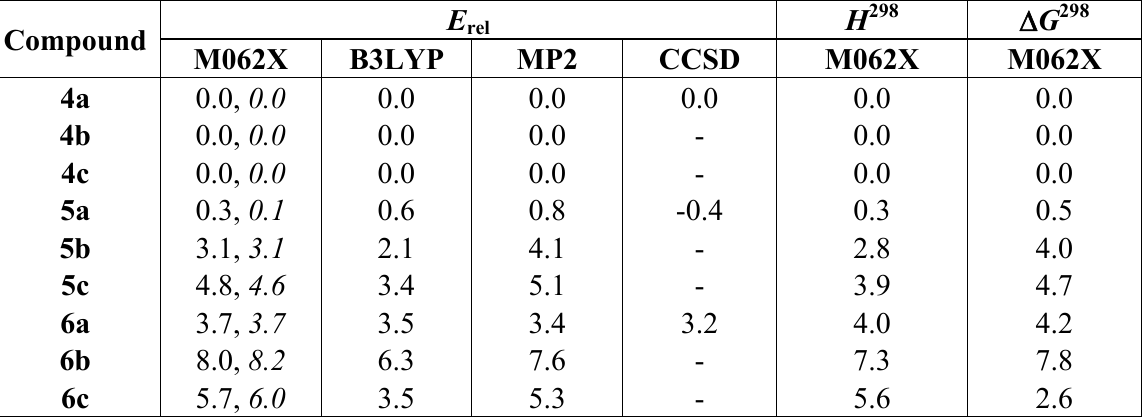
Table 6. Calculated relative energies (kcal/mol) of silaphenylthiolates 4a – 6c a